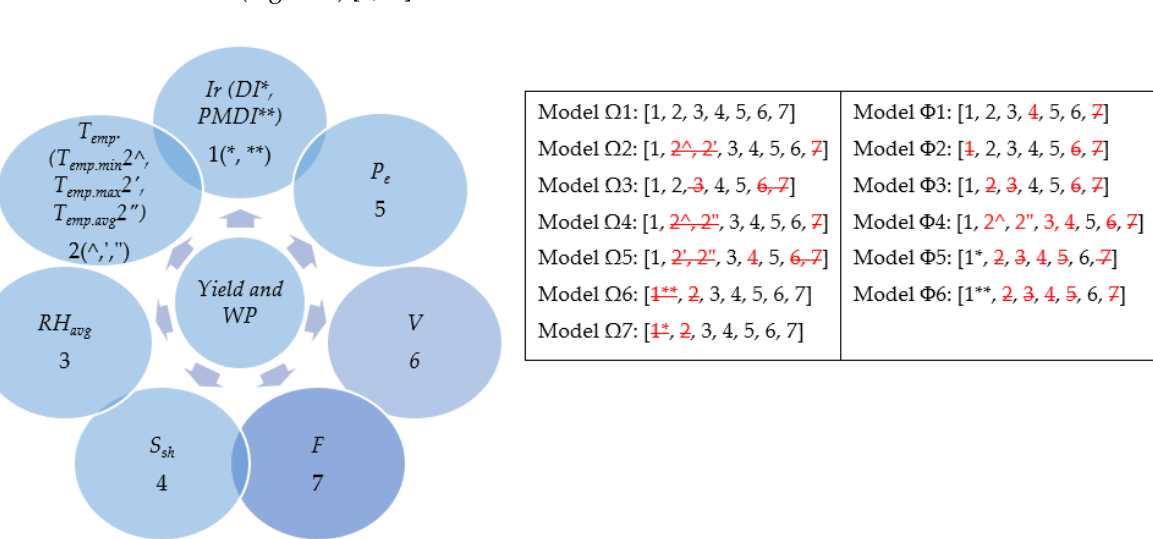
Figure 4. Schematic of the experimental setup.